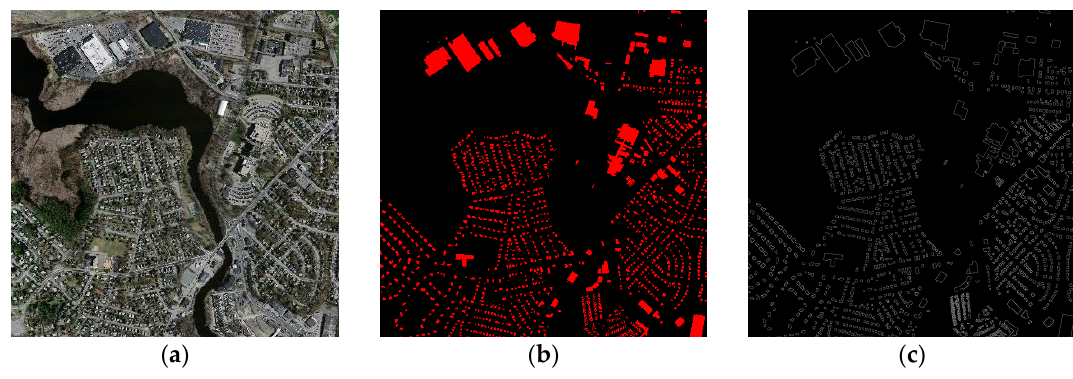
Figure 2. Dataset sample. ( a ) Original image; ( b ) building region map; and ( c ) building edges ground truth map.